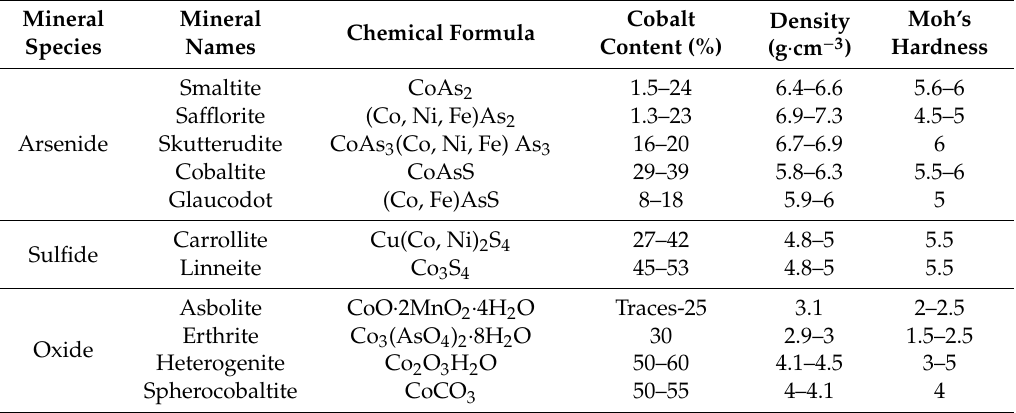
Table 1. The common cobalt minerals and their